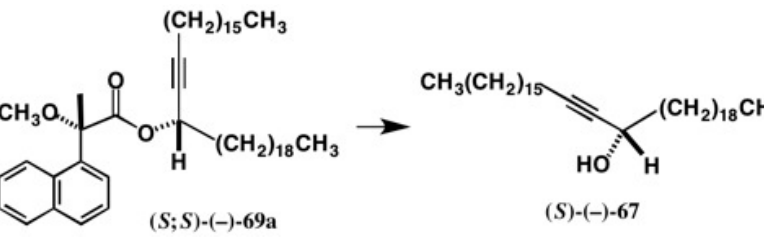
Figure 50. Preparation of enantiopure acetylene alcohol ( S )-( − )- 67 .